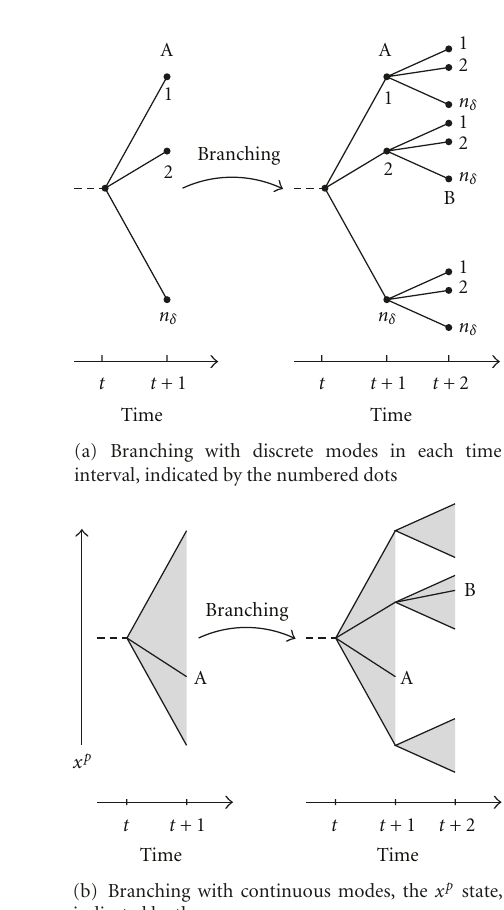
Figure 2: Illustration of branching with discrete modes and continuous modes (the x p state). A indicates the system with one possible mode, and B the system with another mode combination a time step p t